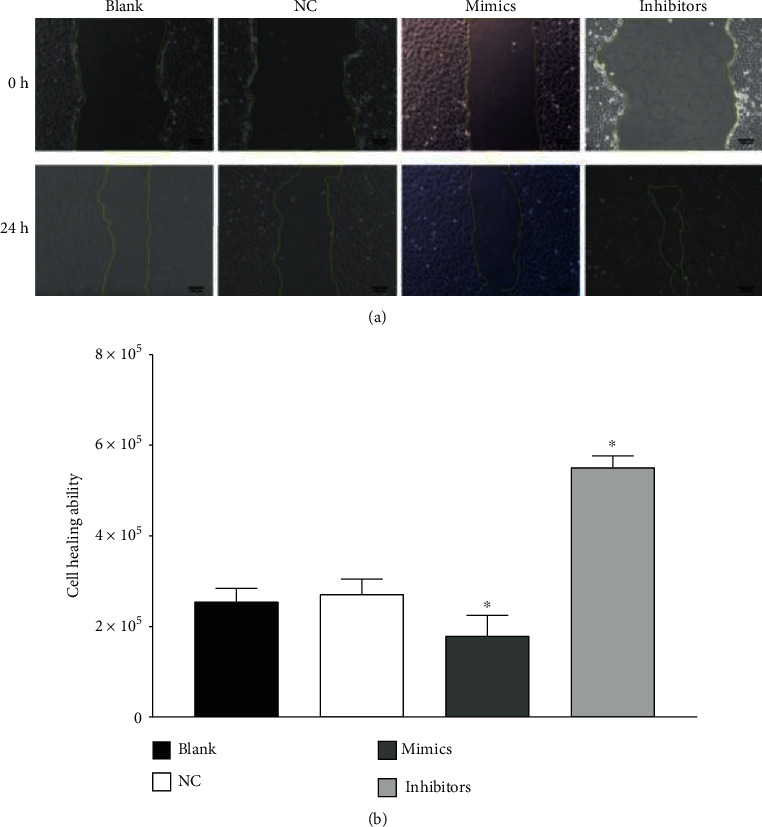
Effect of miR-499a-3p on the migration of HUVECs. (a) Schematic show (magnitude: 100x) of the effects of miR-499a-3p on the migration ability of HUVECs examined by scratch assays after transfection for 24 h. (b) The healing area of the blank, NC, mimics, and inhibitors group after transfection for 24 h. It is calculated by the difference value of the scratching area at t = 0 and t = 24 h. Three random sections from the scratching were chosen and compared for each cell group (n = 3).